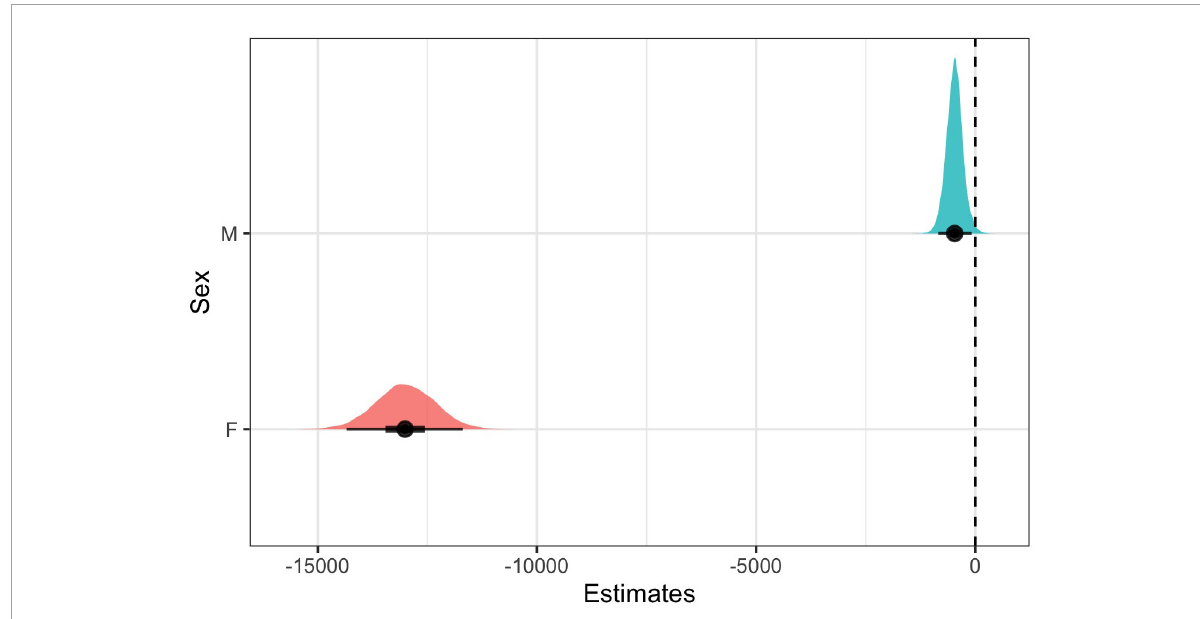
FIGURE7 Coefficient estimates ± 95% credible intervals for male and female models with bandwidth as an outcome and note rate as a predictor. We considered the predictors reliable if the confidence intervals (indicated in black) did not overlap zero. Each point indicates the median posterior density credible interval value, the inner black bars represent the 50% credible interval, and the outer black bars represent the 95% credible intervals. The colored distribution plots indicate the associated uncertainty in the point estimates.